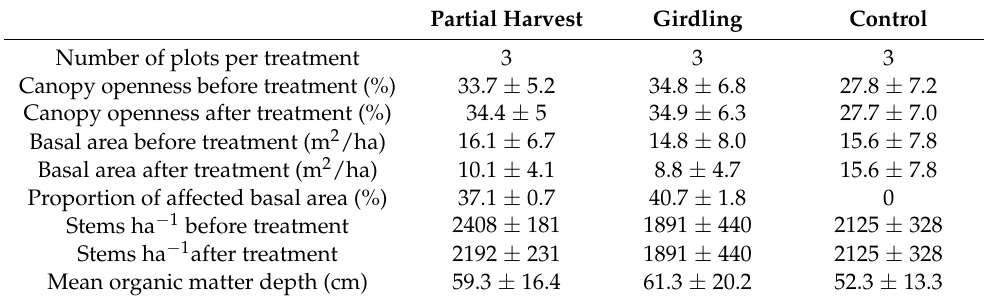
Table 1. Merchantable basal area and the number of stems ha − 1 (mean ± SD) per plot, before and after application of treatments, together with mean organic matter